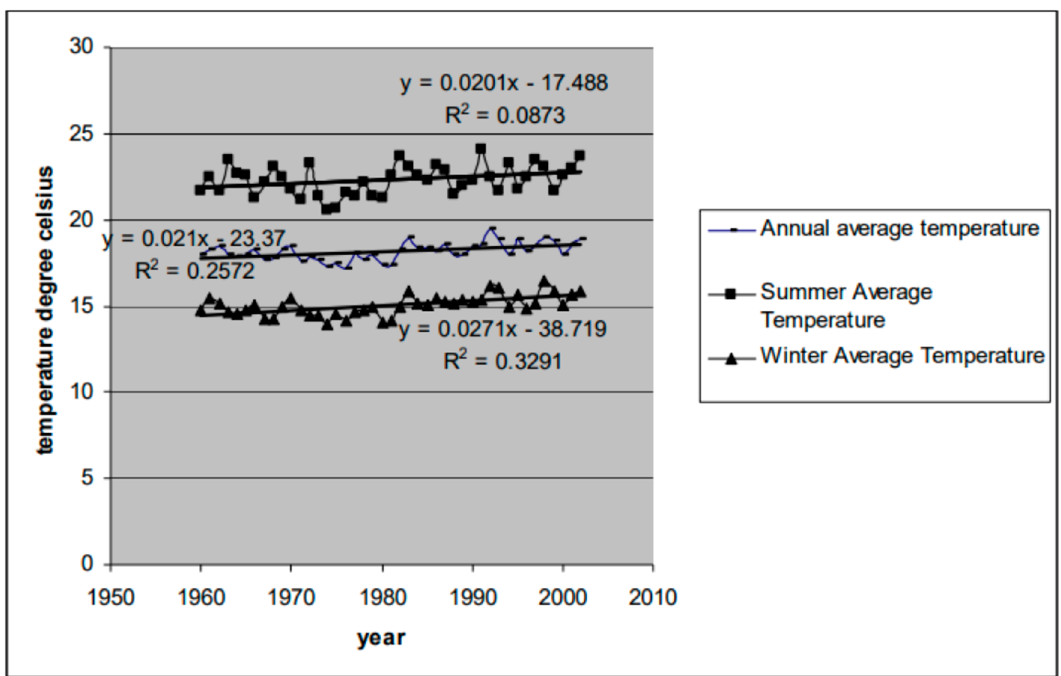
Figure 2. Trend of temperature data in Limpopo Province from 1960 to 2003 [21].